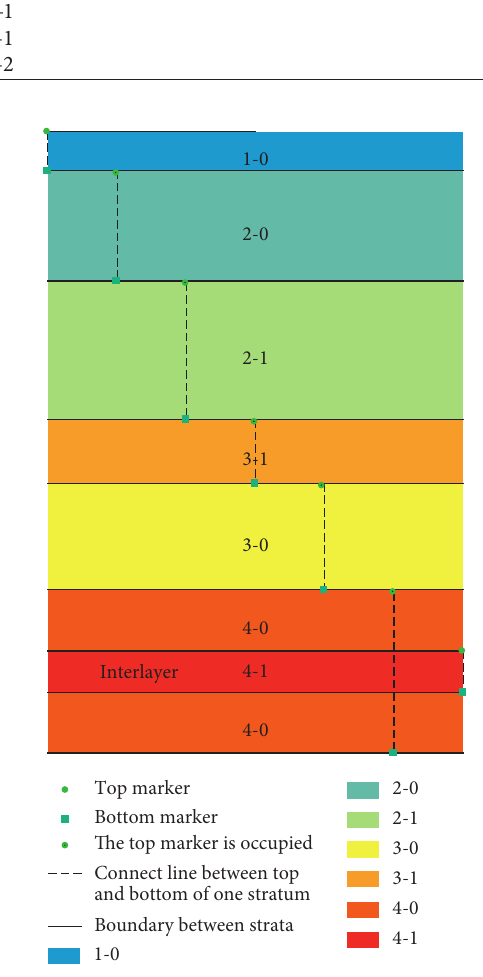
Figure 5: Diagram of occupancy relationship among